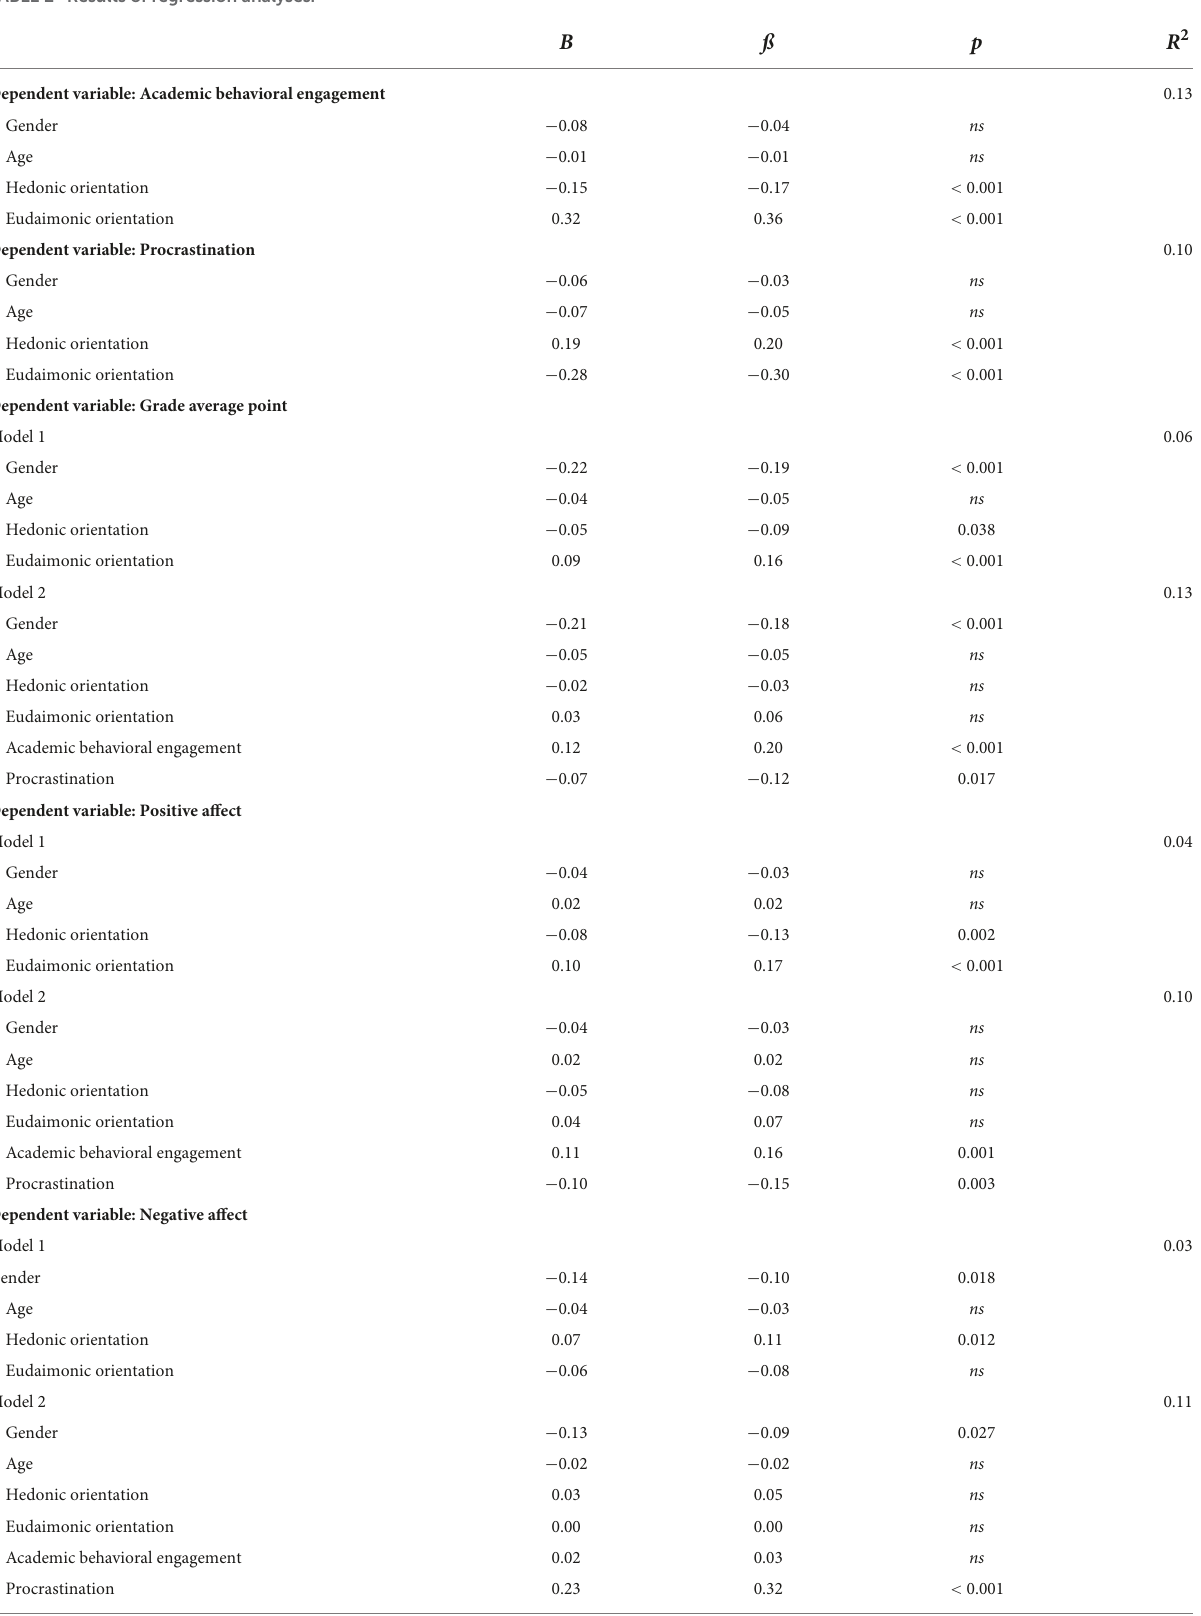
TABLE 2 Results of regression